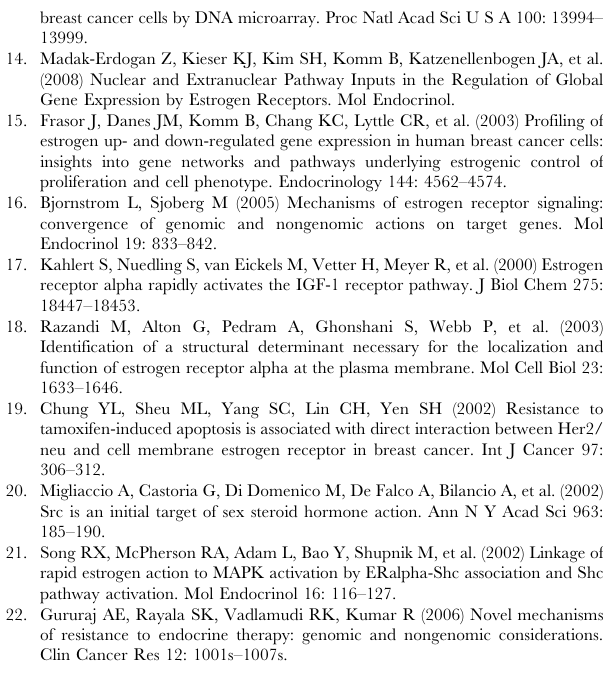
Figure S5 Re-expression of CSK in MCF-7 cells rescues fulvestrant-induced ER a protein degradation. ( A , B ) Effects of E2 and fulvestrant on proliferation and survival of T47D cells. Cells were for up to 6 days ( A ) or 11 days ( B ) in the presence or absence of E2 and/or fulvestrant in the medium, and the live cell numbers in the culture were determined by crystal violet staining. Note that live cell number was not decreased in the presence of fulvestrant even though cells were not proliferated in this condition, either. ( C – E ) Changes in ER a protein expression in T47D cells exposed to fulvestrant. T47D cells infected with pLKO.1 control lentivirus ( C ) or the CSK-KD # 1 shRNA lentivirus targeting CSK ( D ) were exposed to 100 nM fulvestrant or vehicle (ethanol) for 3, 6, or 9 hours (control, no exposure) and then subjected to Western blotting determination of ER a protein expression. Intensities of ER a protein bands were determined by densitometry (E, mean 6 SEM of three independent experiments. Asterisk indicates statistical significance (p , 0.05) against control; sharp indicates significant differences between the pLKO.1- infected and the CSK-KD # 1 infected cells observed when cells were exposed to fulvestrant (p , 0.05, t -test). Figure S6 PP1 or AZD0530 tyrosine kinase inhibitors had no effect on fulvestrant-induced cell death. Cells were exposed to PP1 (0.1–2 m M, A) or AZD0530 (0.1–2 m M, B) for 30 minutes and then exposed to 100 nM fulvestrant in the presence of the same c-Src kinase inhibitors for 5 days. Cell viability was determined by crystal violet staining. Representative crystal violet staining images are shown. Amounts of stained cells were determined by spectrometry as shown in the bar graphs (mean 6 SEM of three independent experiments; asterisk indicates statistical significance p , 0.05 against the vehicle control, sharp indicates significance against the absence of AZD0530). Figure S7 c-Src phosphorylation and kinase activity in MCF-7 cells. ( A ) Fulvestrant does not induce c-Src phosphor-